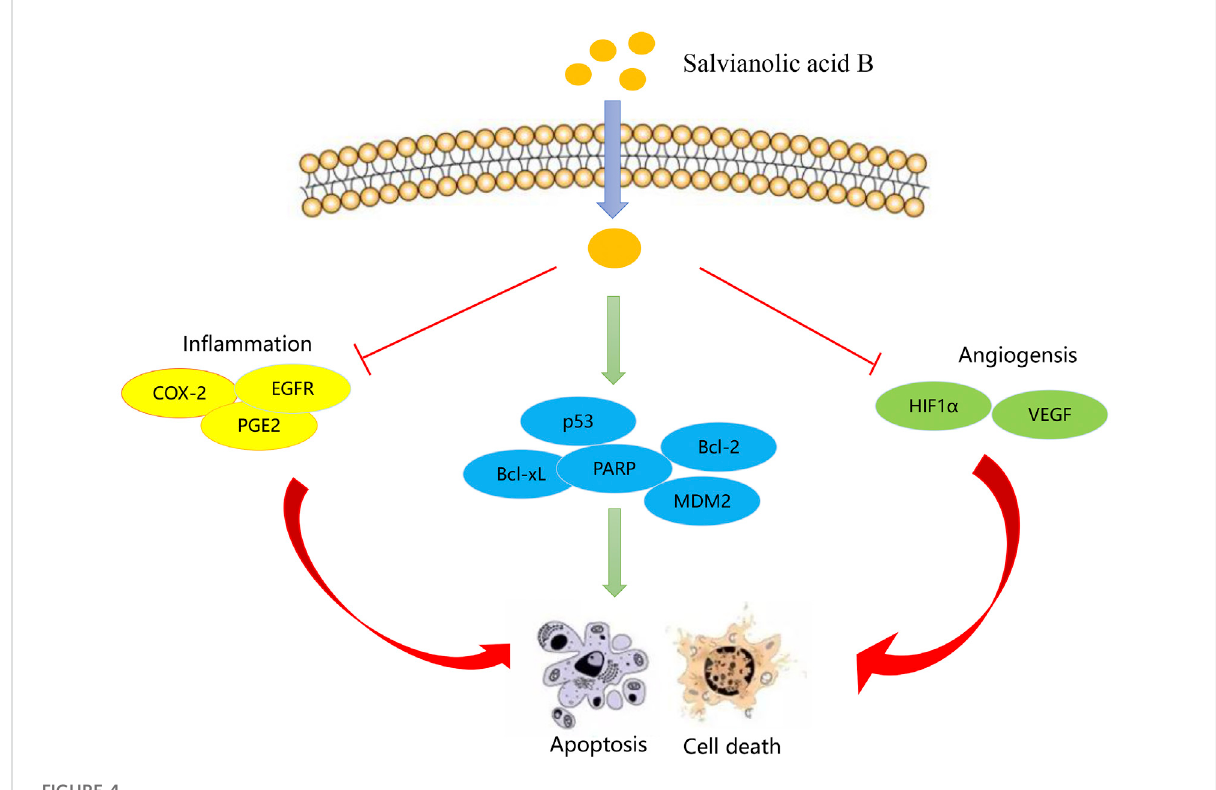
Molecular mechanism of Salvianolic acid B inhibiting